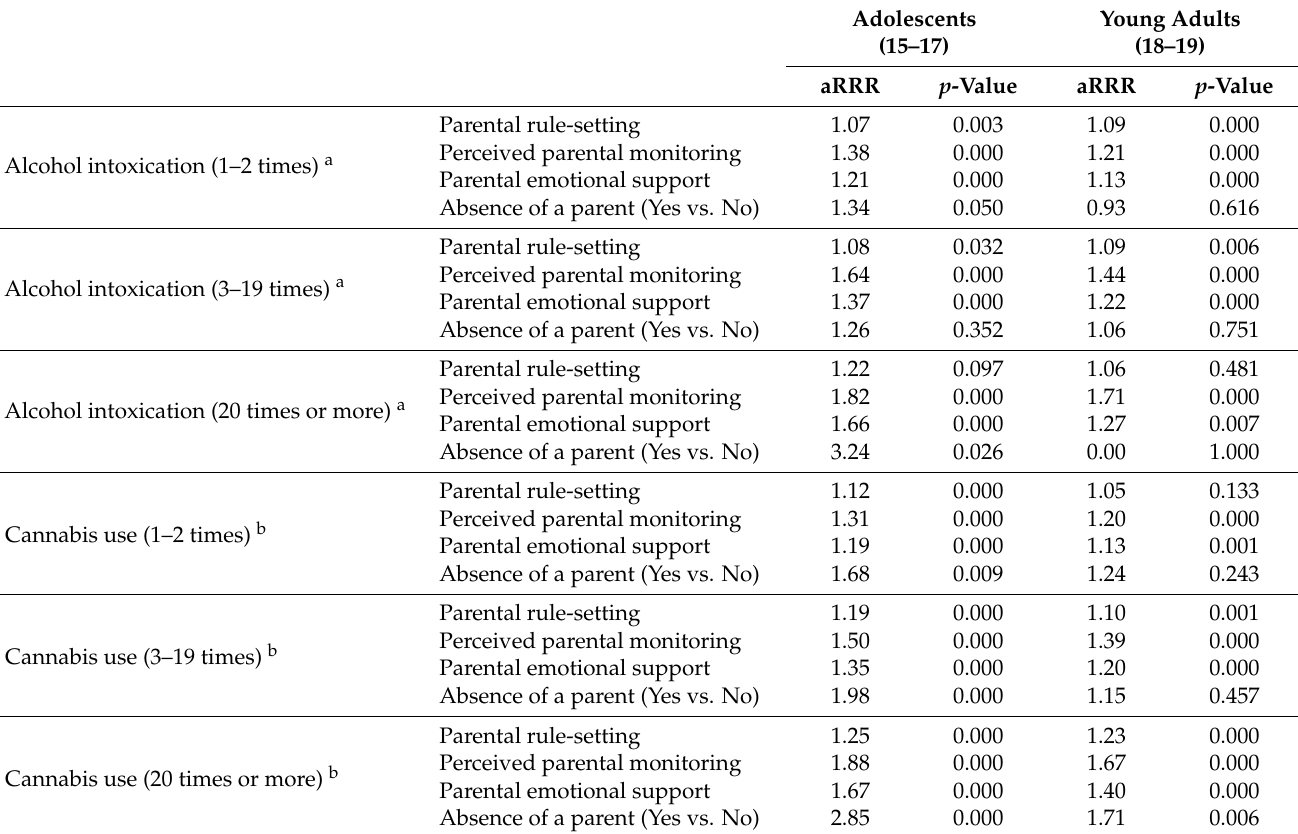
Table 3. Relative risk ratios (RRR) adjusted for